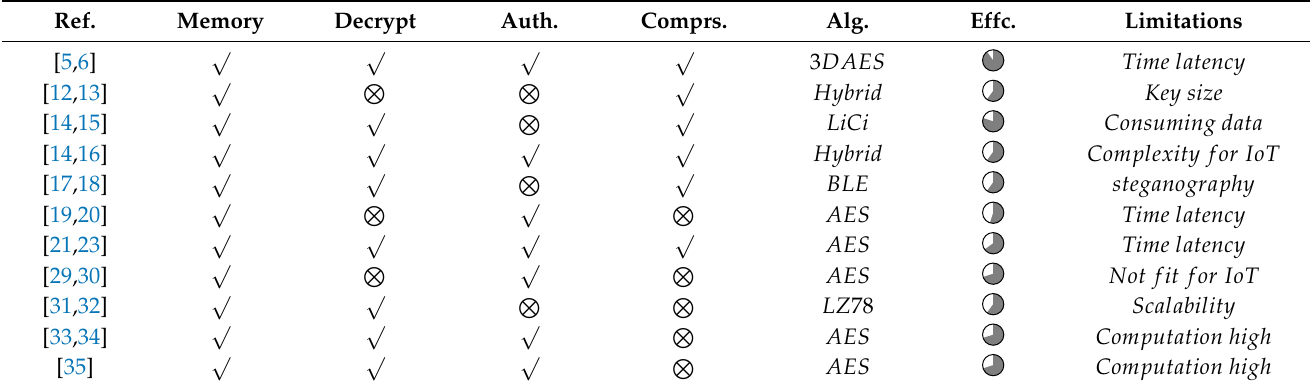
Table 1. State-of-the-art AES improvement for IoT Security Enhancement.